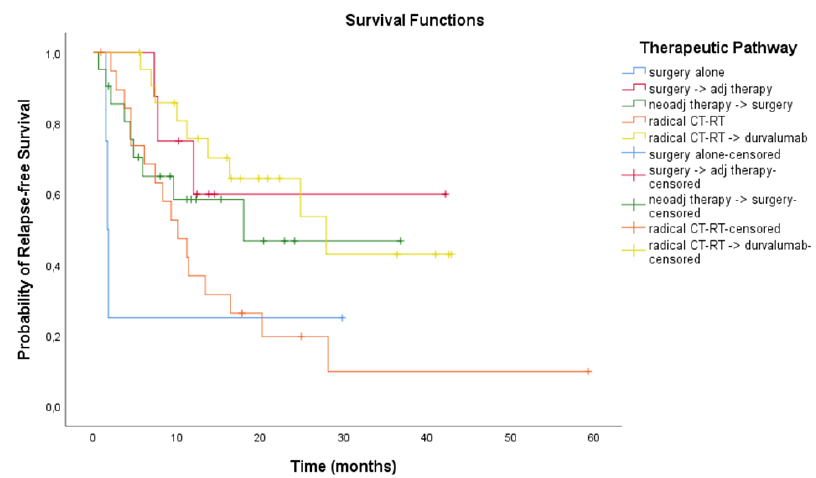
Figure 14. Kaplan–Meier curves of estimated relapse-free survival according to treatment modality in stage IIIB-C patients treated after 2018. CT-RT, chemo-radiation therapy.